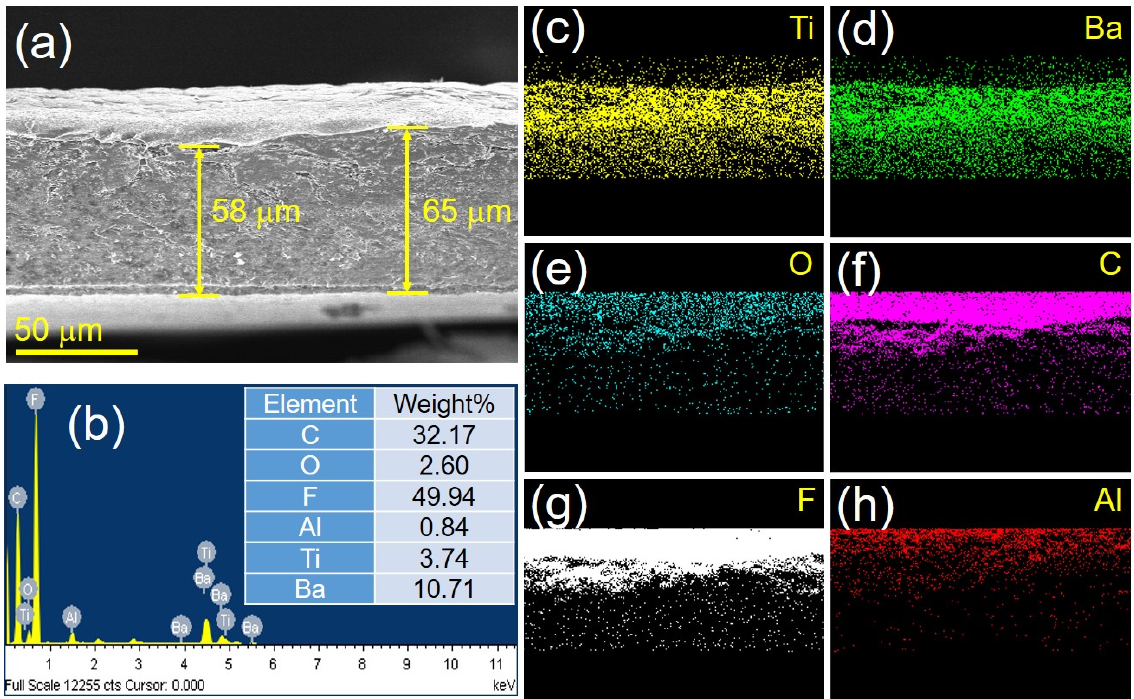
Figure 3. ( a ) Cross ‐ section FESEM micrograph of the as ‐ prepared PBC film; corresponding ( b ) EDS analysis; ( c – h ) elemental mapping of the PBC film. analysis; ( c – h ) elemental mapping of the PBC